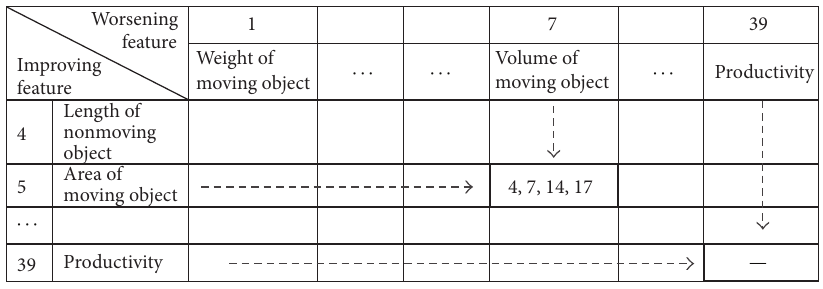
Figure 1: An example of the contradiction